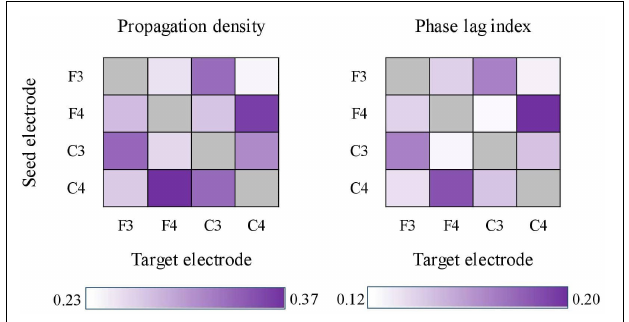
FIGURE 5 | Heat-maps showing propagation density (left) and corrected phase lag indices (cPLIs) between electrode pairs. Both heat-maps show a tendency for bi-directionally higher values between electrodes located in the anterior–posterior axis (e.g., F4–C4 and